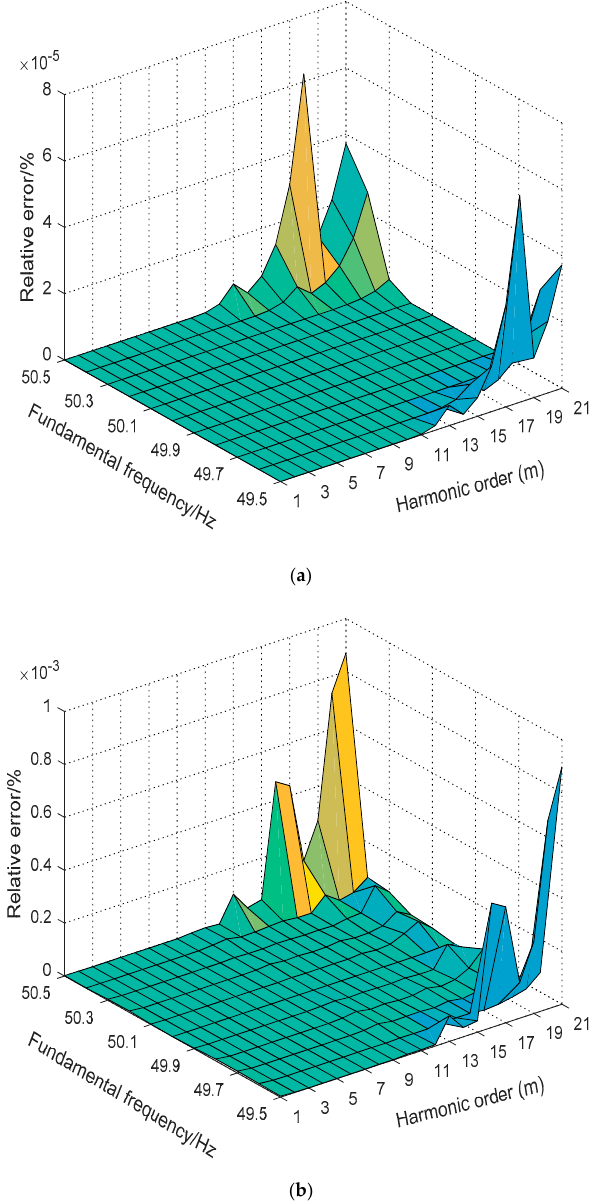
Figure 6. Measurement error of the six-term MSOW. ( a ) Amplitude relative error and ( b ) phase relative error.